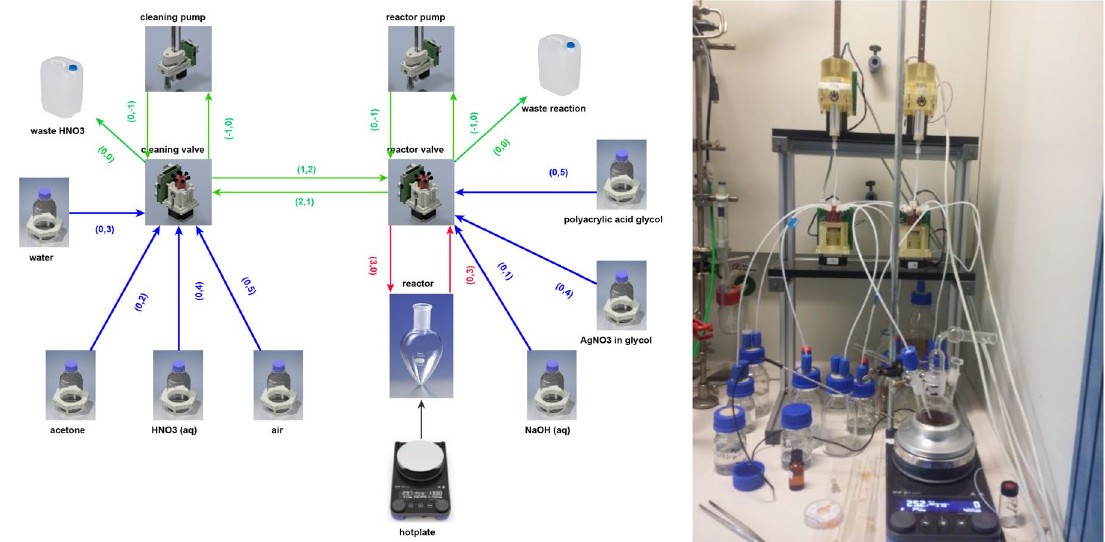
Figure 2. (Left) Graph scheme of the Chemputer platform employed for nanoparticle synthesis rendered from a GraphML 18 file (SI: reaction_graph_AgNP.graphml). Icons/pictures represent graph nodes and contain metadata for the computer control and available volumes. All these metadata are required by the API (the “Chempiler” 19 ). Arrows represent connections; the black arrow between the hotplate and the reactor a temperature control connection, all other arrows represent tubing with metadata such as internal volume and the connection information in parenthesis. For example, “(0, 4)” encodes a connection originating from port 0 (default for storage vessels) and connects to port 4 (on a valve). Directions of arrows encode possible liquid movement directions. Green arrows represent tubing in the Chemputer backbone, the blue connections tubing to storage flasks and the red ones tubing to reaction vessels. Note that arrow colours are only included for clarity and are not relevant to the automation platform and code, also note that two arrows pointing in opposite directions encodes one piece of tubing with no restrictions on flow direction. For more in-depth discussion of the graph and its software implementation into the Chemputer, refer to 16,19 . (Right) The actual physical implementation of the Chemputer used for our synthesis.